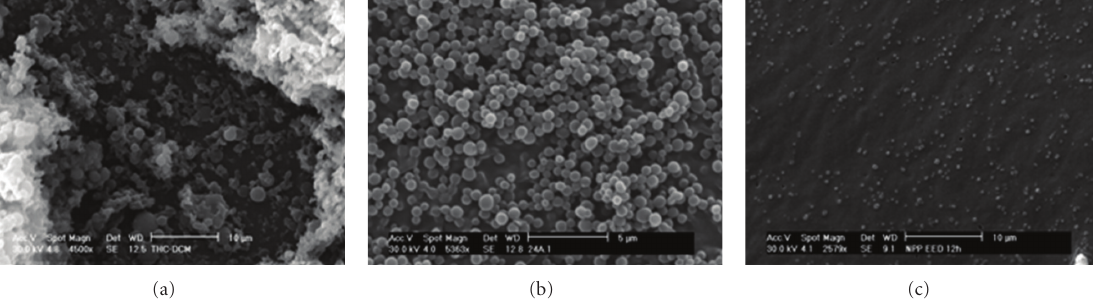
Figure 4: SEM micrographs of CB13-PLGA nanoparticles obtained by three di ff erent procedures: (a) SEV-Us, (b) SEV-FF, and (c) NPP. The longitude of the bar indicates a reference value of the dimension of the particle.